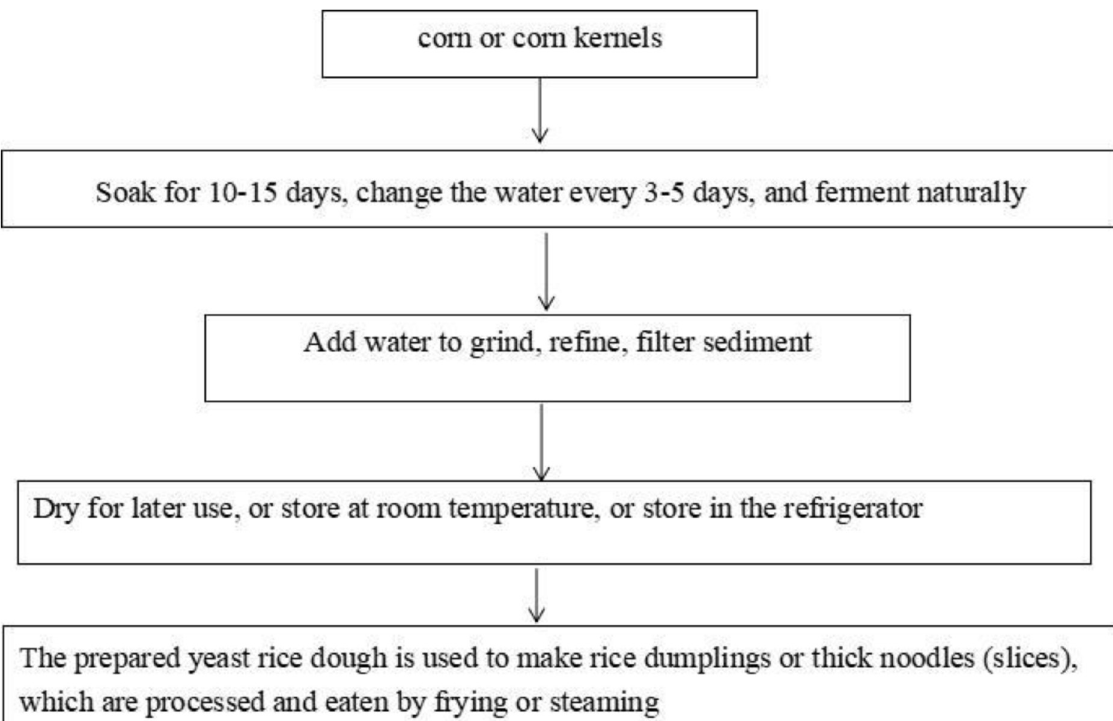
Fig 1. The production process of homemade fermented corn flour products.